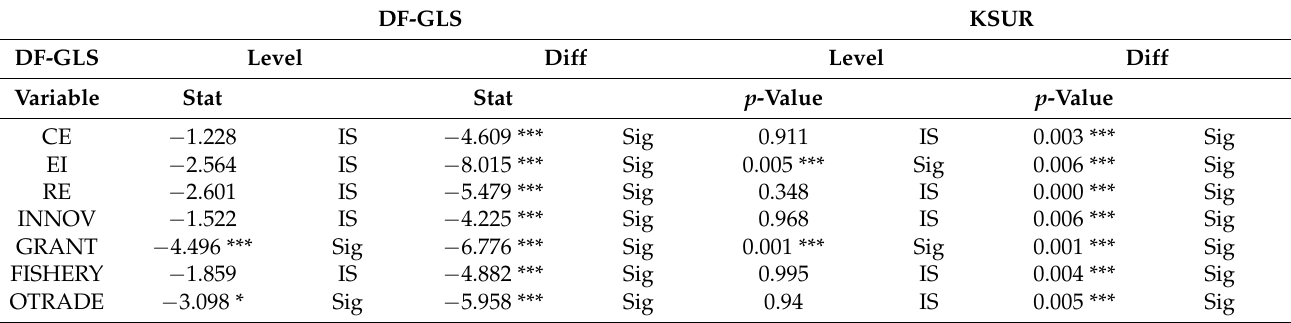
Table 4. Unit root